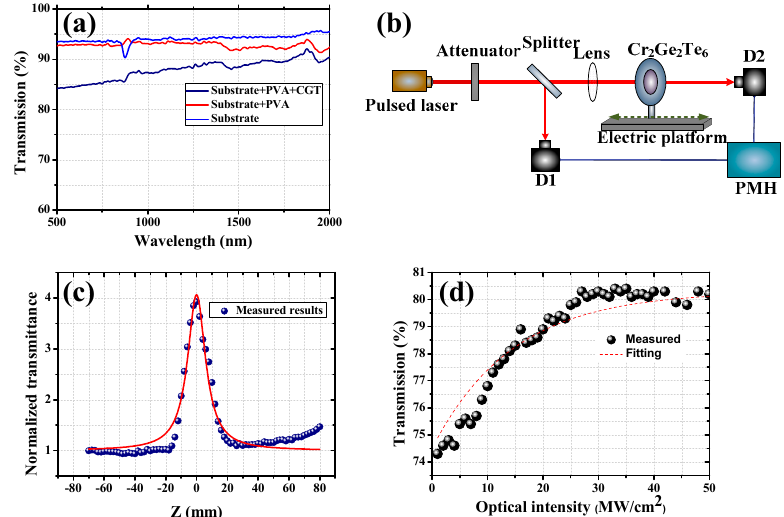
Figure 4. ( a ) Linear absorption spectra of the Cr 2 Ge 2 Te 6 ‐ PVA modulator; ( b ) schematic of the Z ‐ scan system; ( c ) open ‐ aperture Z ‐ scan results of the Cr 2 Ge 2 Te 6 ‐ PVA film; ( d ) power ‐ dependent nonlinear absorption property of the Cr 2 Ge 2 Te 6 ‐ PVA film.